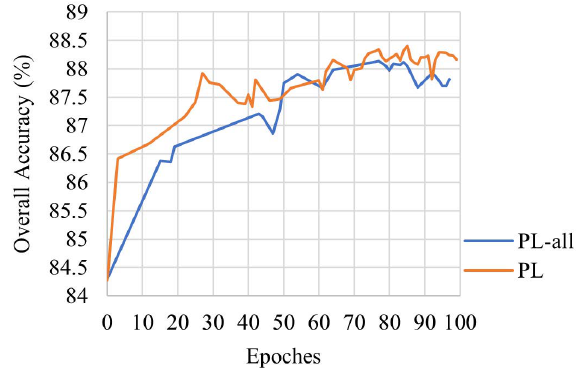
Figure 6. Comparison of overall accuracy of validation on train- ing data in 100 weak-label setting between two pseudo-label up- date